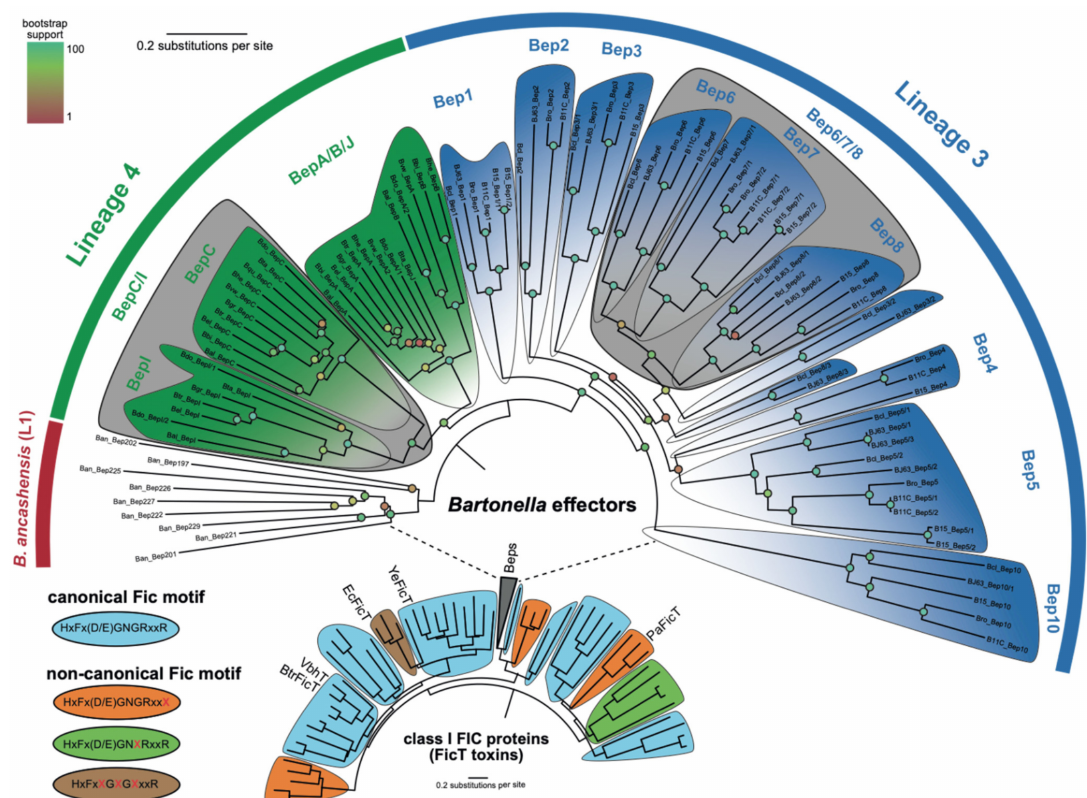
Figure 1. Phylogeny of class I Fic proteins. An extension of the class I Fic phylogeny published in [19], which shows the extended Bep phylogeny. The Bartonella Beps form part of a rhizobial clade and have ca. 35% sequence identity with them. Each clade is colored by the representative FIC motif as some Bep clades show a lot of diversity. The BepA/B clade groups together but shows a progressive change between the canonical and non-canonical FIC